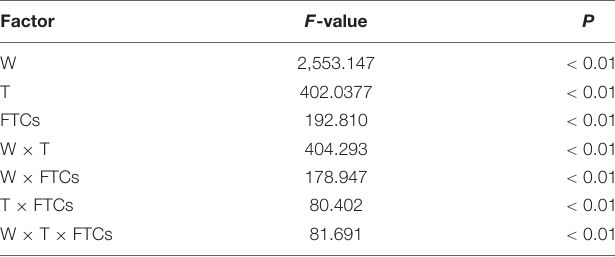
FIGURE 4 | Gauss fit between N 2 O flux and soil moisture under three different thawing temperatures (T 5 –5 ◦ C, T 10 –10 ◦ C, and T 20 –20 ◦